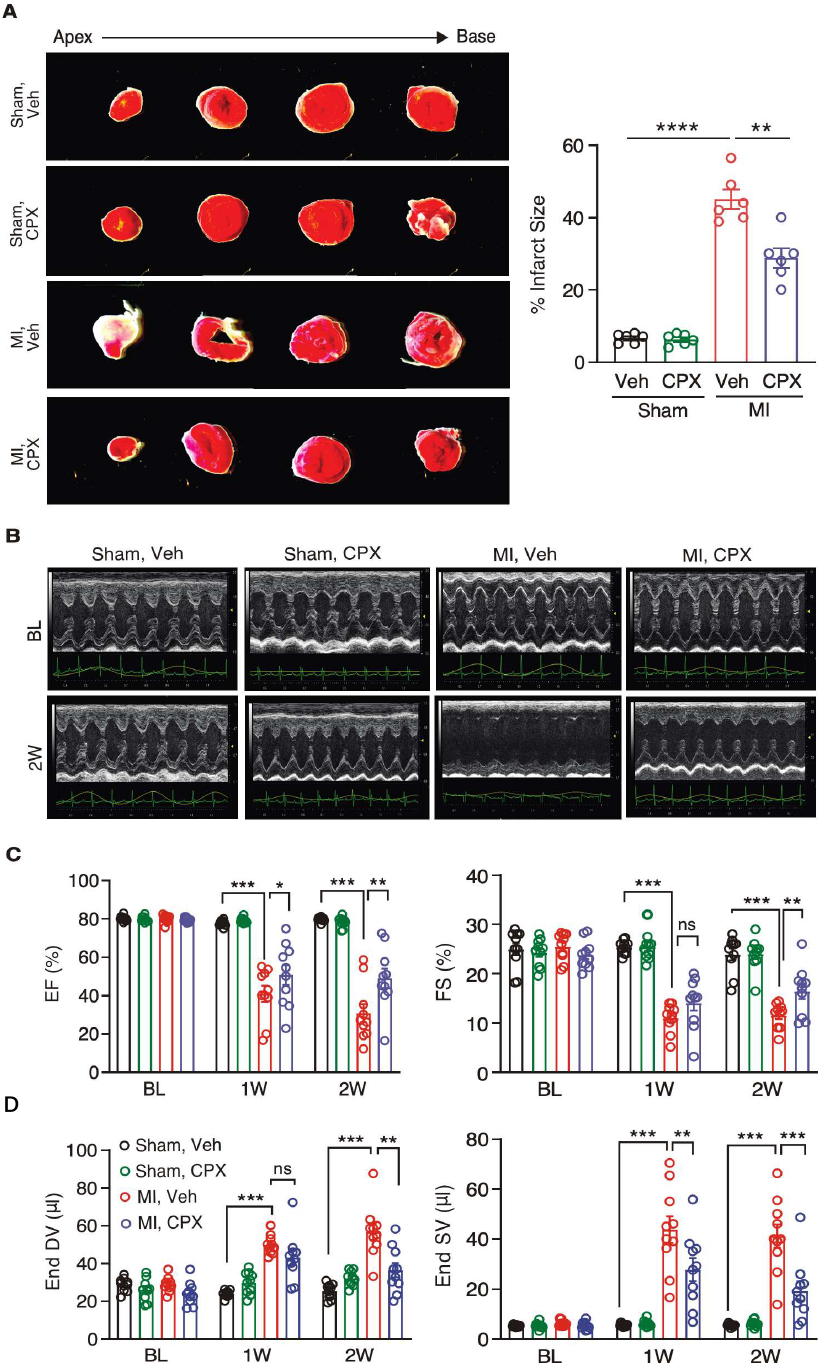
Figure 3. Ciclopirox reduces scar formation and preserves cardiac function after MI surgery. ( A ) TTC (2,3,5-Triphenyltetrazolium chloride) staining of hearts of vehicle and CPX-treated mice after 14 days post-Sham or MI surgery ( n = 6 per group). The infarct area was calculated from the apex to the base of the heart sections. ( B ) Representative echocardiographic images of the vehicle and CPX-treated mice after Sham or MI surgery. ( C ) Ejection fraction (EF) and fractional shortening (FS) were partially recovered in CPX-treated mice in MI surgery-induced mouse HF model. n = 10/10/10/10 for the four groups of Veh Sham/CPX Sham/Veh MI/CPX MI. ( D ) End systolic and diastolic volumes were reduced in CPX-treated mice in MI surgery-induced mouse HF model. * p < 0.05, ** p < 0.01, *** p < 0.001, **** p < 0.0001 by Two-way ANOVA with Tukey’s multiple comparisons test.